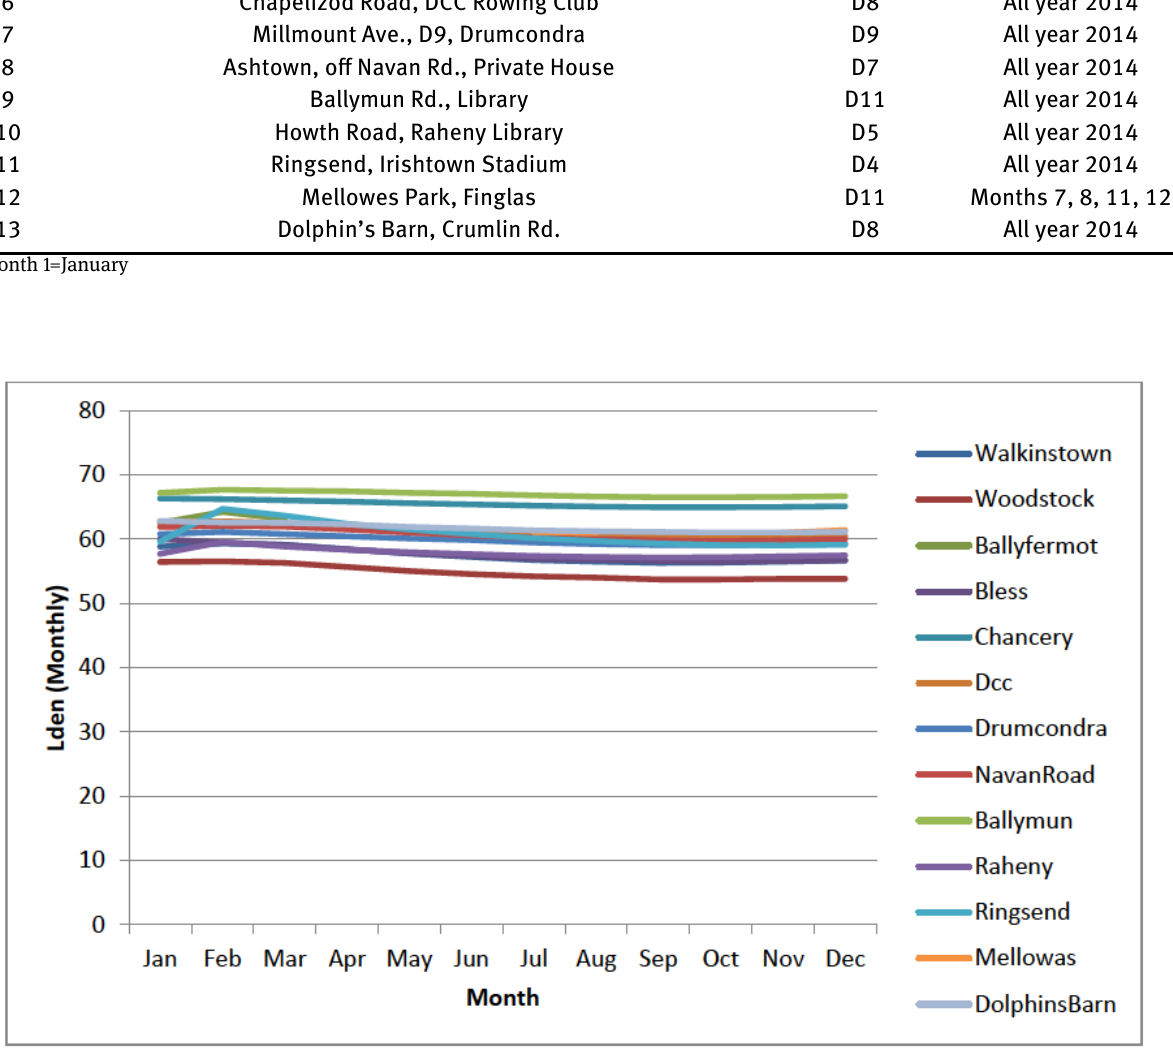
Supplementary Figure 1: L den at monthly